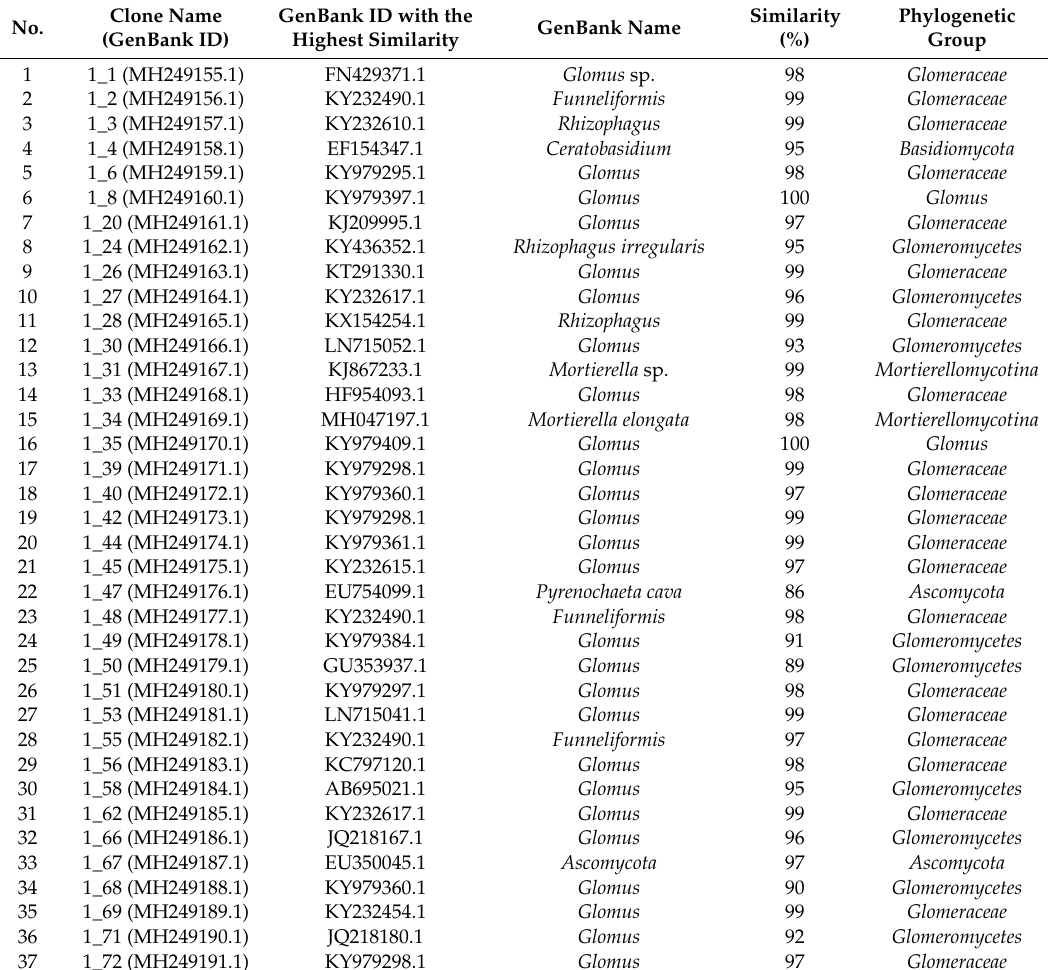
Table 4. Comparison of sequenced clones from the rhizosphere of Arundo donax without SS in the soil with 18S rDNA sequences of fungi with the highest similarity using Nucleotide